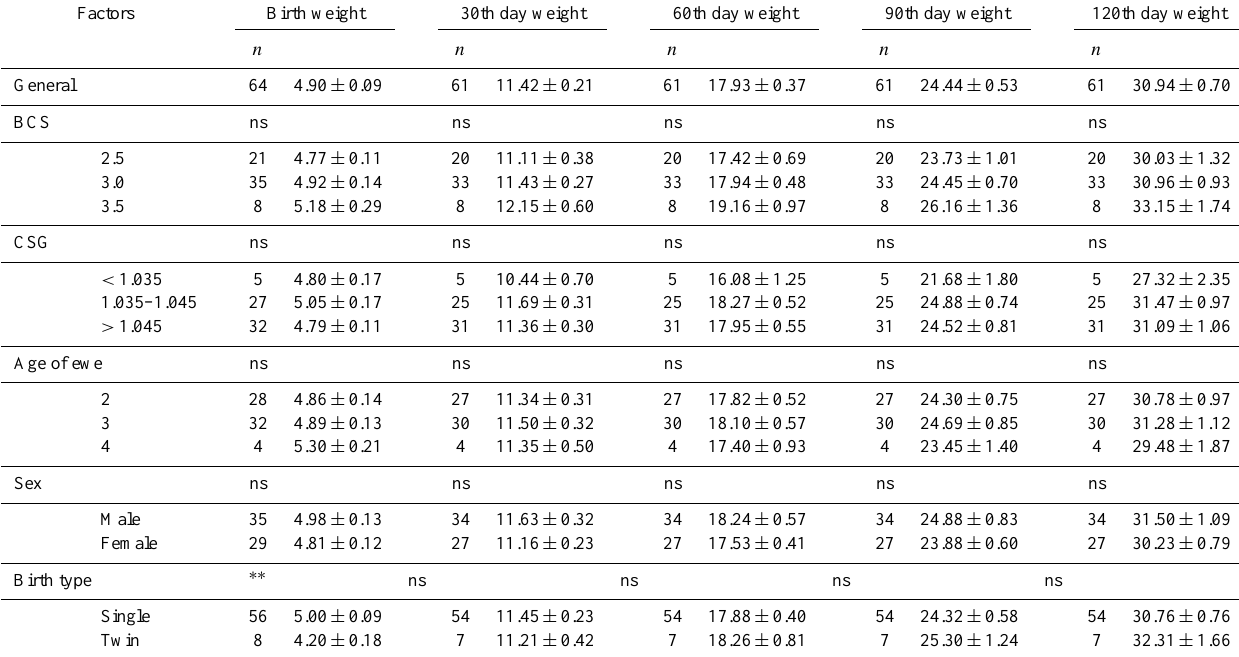
Table 2. Least-squares means ( ± SE) of body weights of lambs according to body condition score (BCS) at lambing, colostral specific gravity (CSG), age of ewe, sex and birth type of